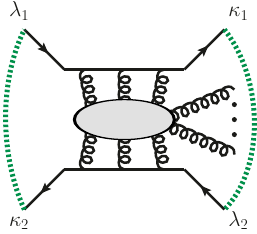
Figure 1 . Contraction of the open ( D s (cid:0) 4)-dimensional spinor indices for amplitudes with external quarks: each quark line closes upon itself. Indices connected by red dashed lines are traced over.